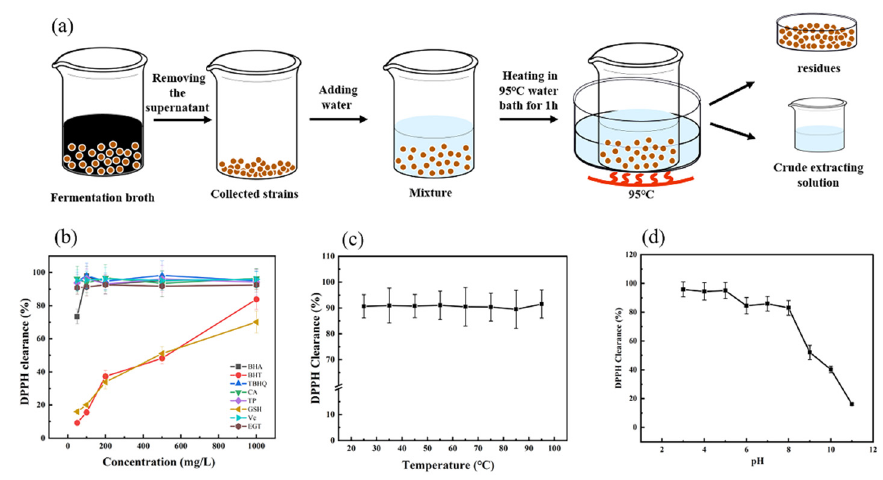
Figure 5. ( a ) Extraction of ergothioneine; ( b ) DPPH scavenging ability of EGT, GSH VC, TP, CA, BHA, BHT and TBHQ; ( c ) Effect of temperature on scavenging DPPH by ergothioneine from Panus conchatus ; ( d ) Effect of pH on scavenging DPPH by ergothioneine from Panus conchatus .